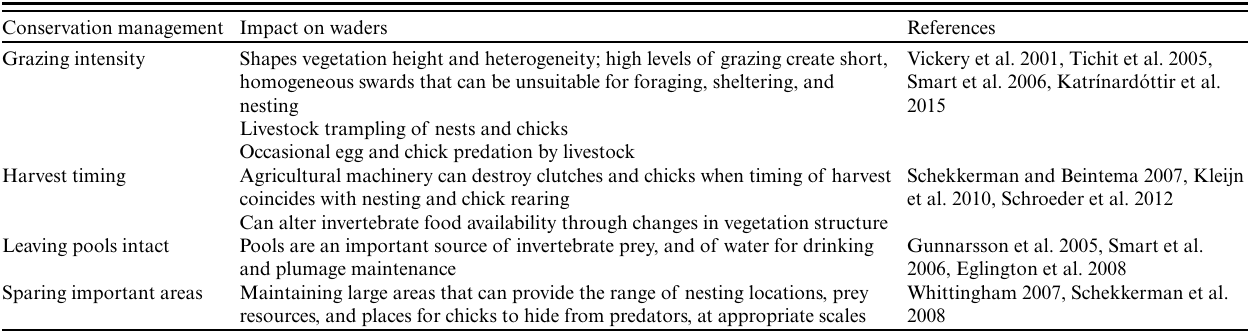
Table 1 . Details of the four agricultural land management issues likely to be of specific importance for breeding waders in lowland Iceland, and the mechanisms through which they can influence breeding wader distribution and demography.